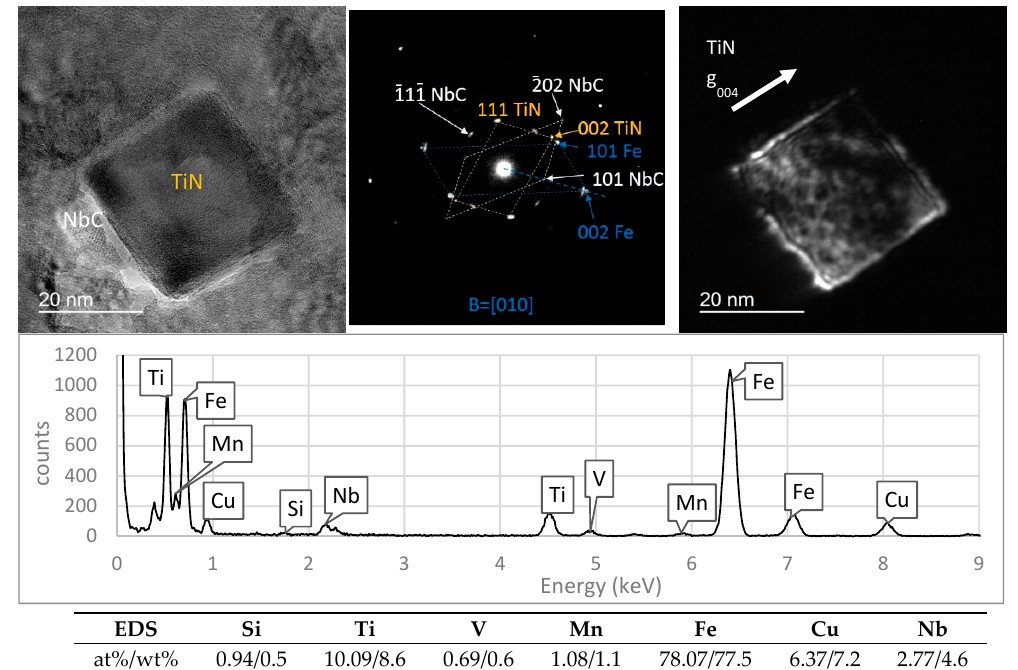
Figure 7. Bright field-Dark field (BF-DF) images and SADP from a precipitate in low-Nb steel austenitized at 1200 °C for 1 h.